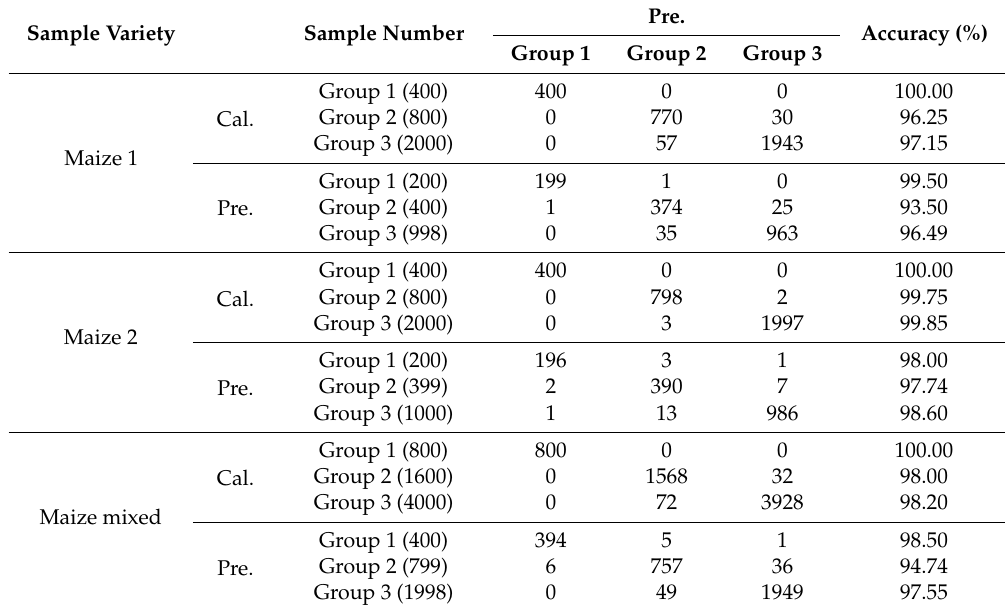
Table 3. The classification accuracy of SVM models of three groups using full spectra.